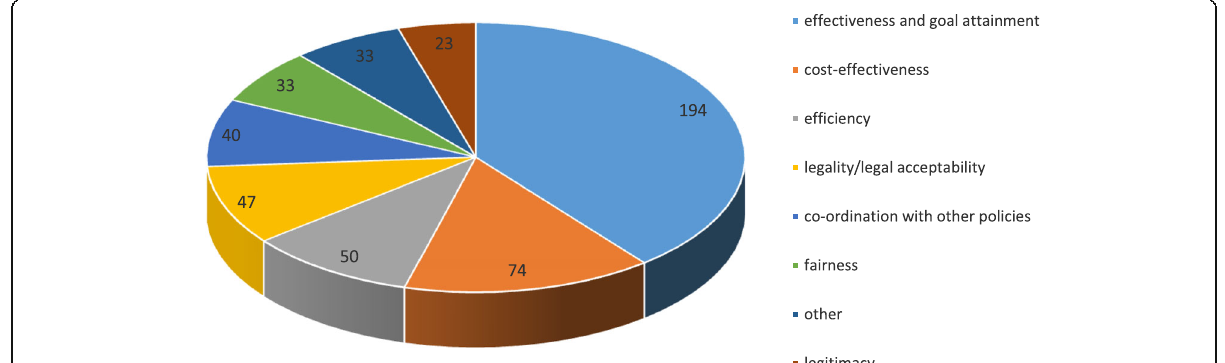
Fig. 8 Evaluation criteria, all jurisdictions